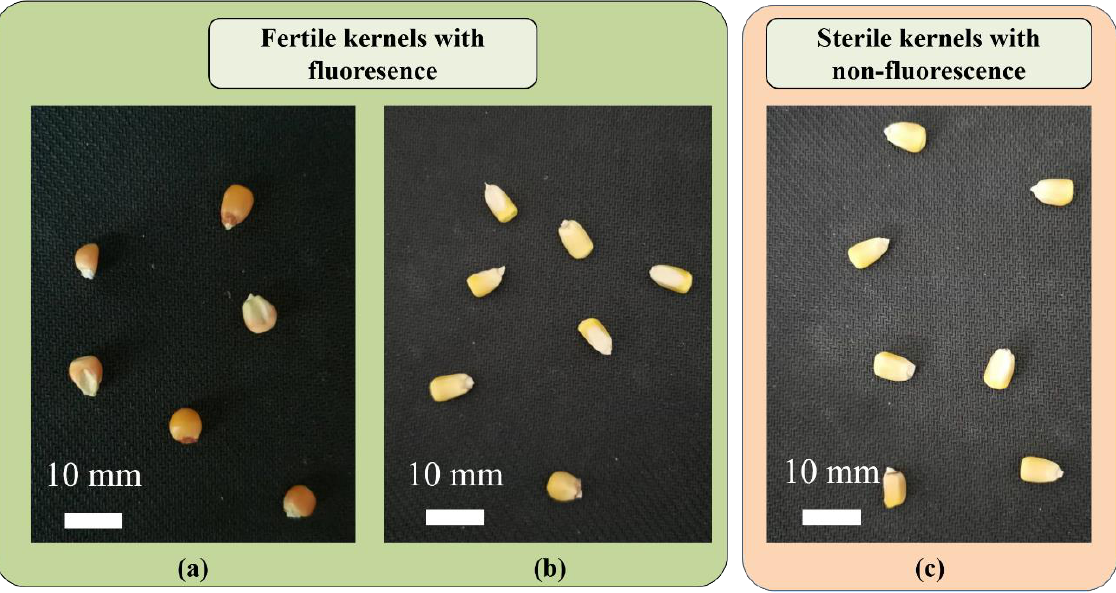
Table 1. Categories and types of maize kernel samples.